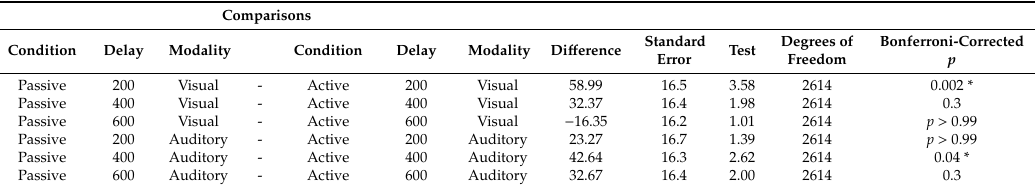
Table 1. Planned post-hoc comparisons. Comparisons between time compression values in the active and passive conditions at di ff erent action-outcome delays, separately for each modality. For each comparison, we reported the mean di ff erence, the standard error, the value of the statistic, the corresponding degrees of freedom and the associated Bonferroni-corrected p value. Asterisks indicate significant results at p < 0.05 Bonferroni corrected.